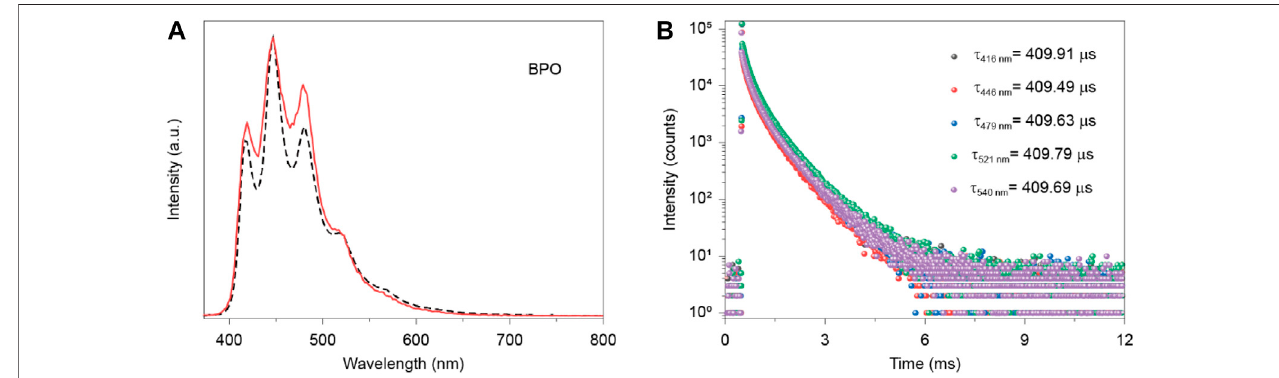
FIGURE 2 | (A) Steady-state PL (dotted line) and decay emission spectra (full line) ofthe host BPO in crystal excited by 383 nm. Inset image show the photograph under 365 nm UV light. (B) Lifetime pro fi les of decay emission bands at 416, 446, 479, 521 and 540 nm for the host (BPO) excited by 396 nm.